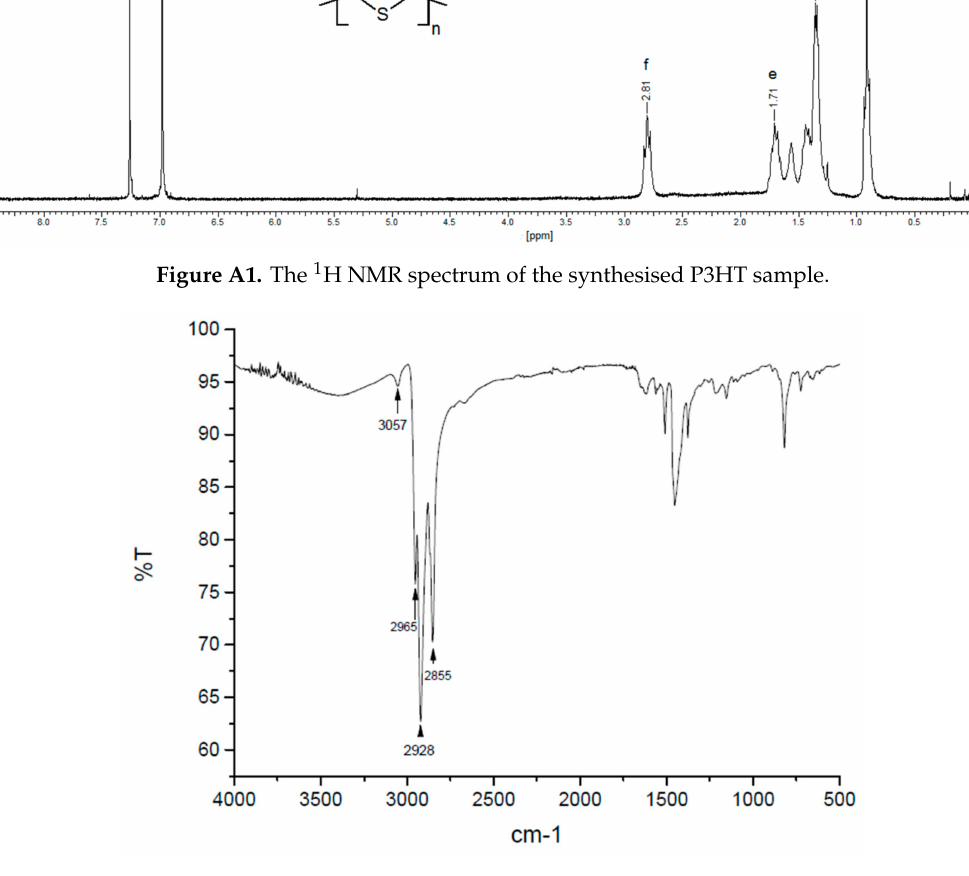
Figure A2. The FT IR spectrum of the synthesised P3HT